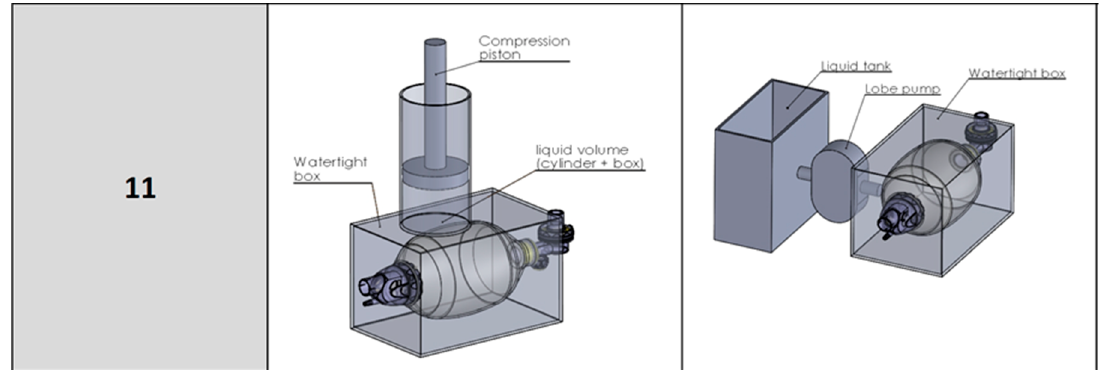
Figure 13. Two hypothetical solutions for the new row added to the chart (row 11), as a consequence of the new PSN branch shown in Figure 12 (see [71] for the full size view).